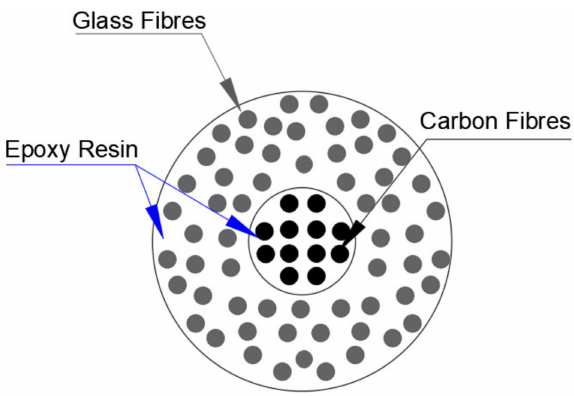
Figure 22. Schematic diagram of a CF–GFRP rod [73]. Modified for explanation.